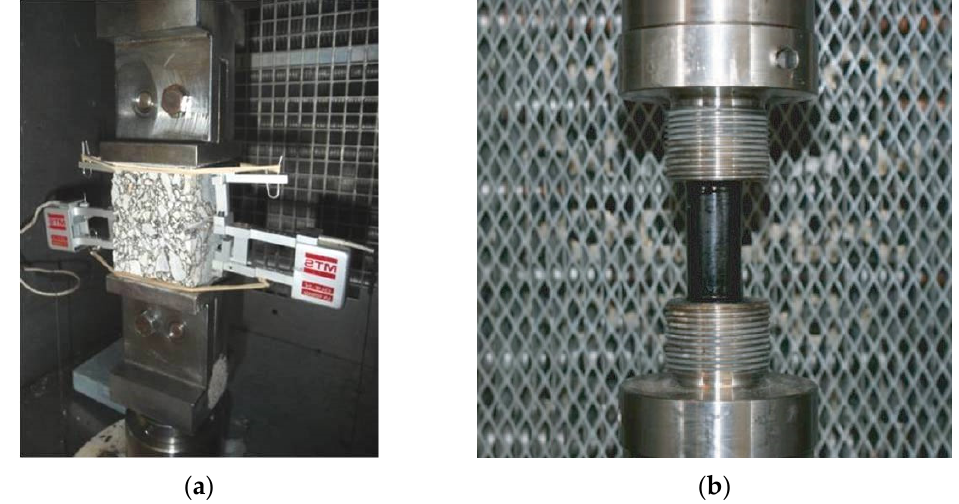
Figure 2. EBADE tests set up for ( a ) prismatic asphalt mixture and ( b ) cylindrical asphalt bitumen specimens.